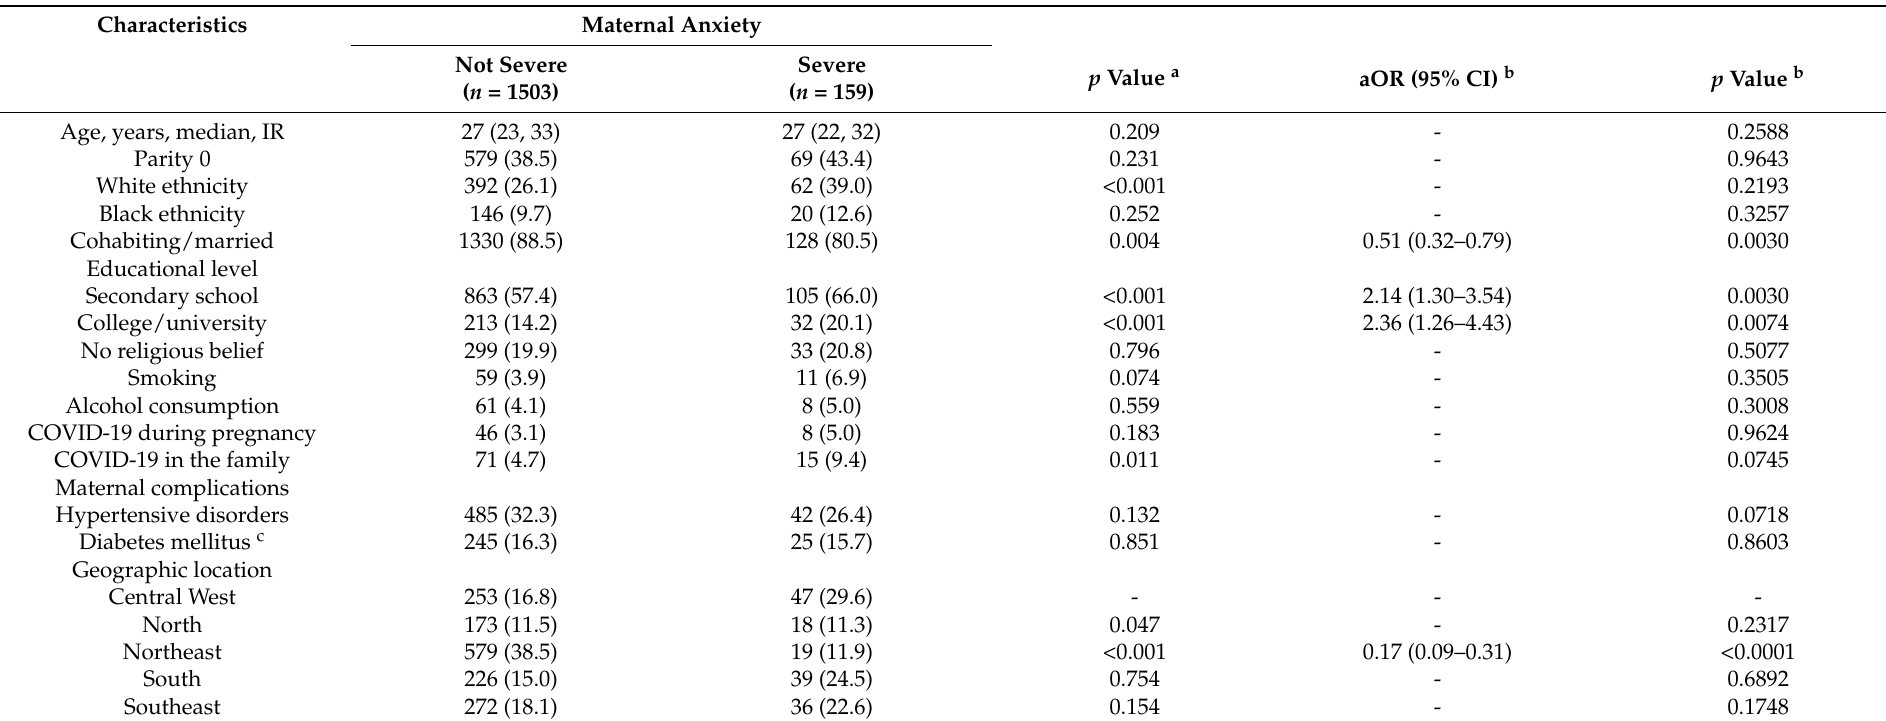
Table 4. Characteristics of women, complications during pregnancy, and Brazilian geographic regions according to severe maternal anxiety as assessed by the Beck Anxiety Inventory during the COVID-19 outbreak (June–August, 2020).